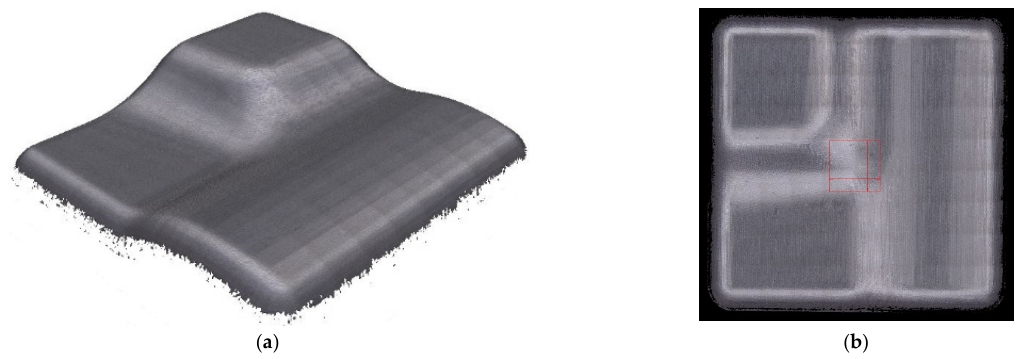
Figure 9. An example of the result of the scanned surface of a single sample on a Alicona Infinite Focus G5 ( a ) 3 + 2 milling, tool axis inclinations β f = 5°, β n = 10°, ( b ) red square area (4 mm × 4 mm) for surface roughness measurement.